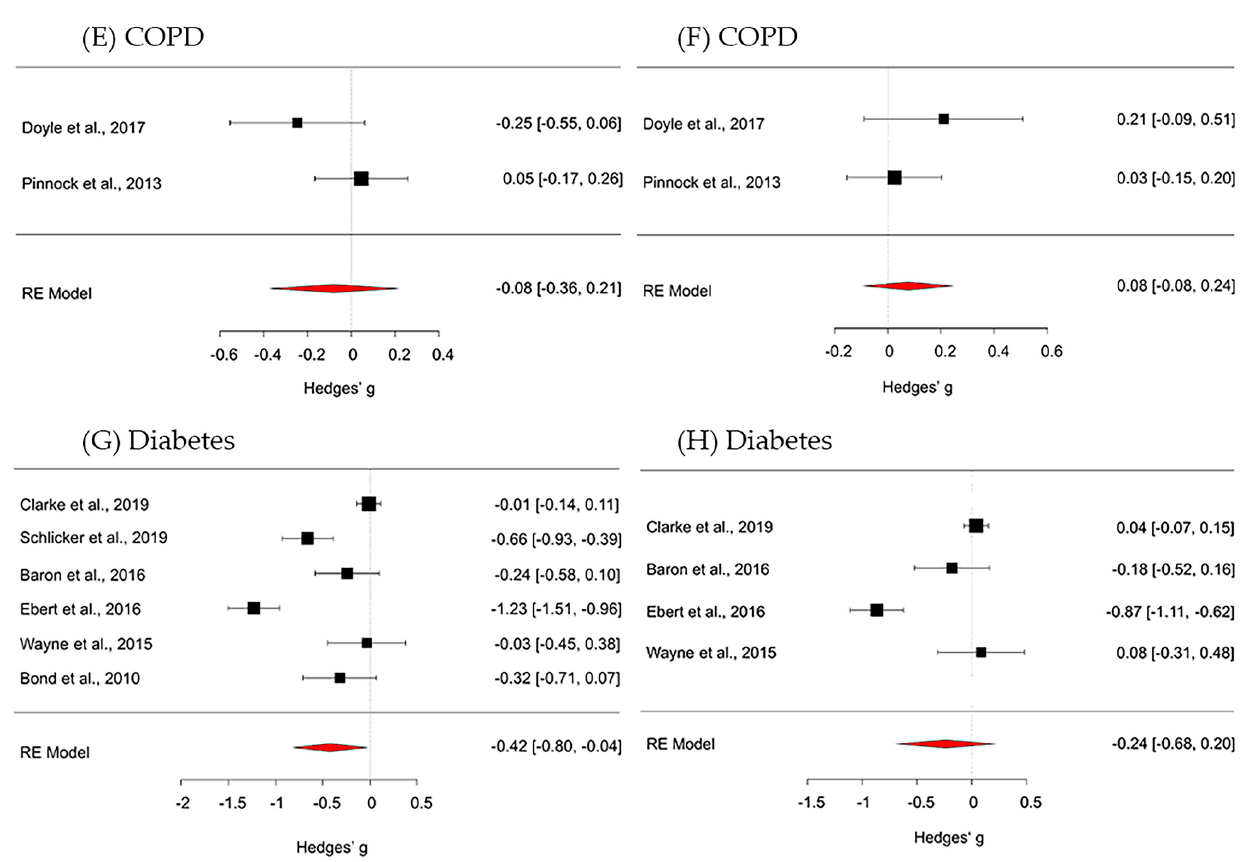
Figure 3. Forest plots on depression outcomes (panel A —overall effect; panel C —cardiovascular disease; panel E —chronic obstructive pulmonary (COPD) disease; panel G —diabetes) and on anxiety outcomes (panel B —overall effect; panel D —cardiovascular disease; panel F —COPD; panel H